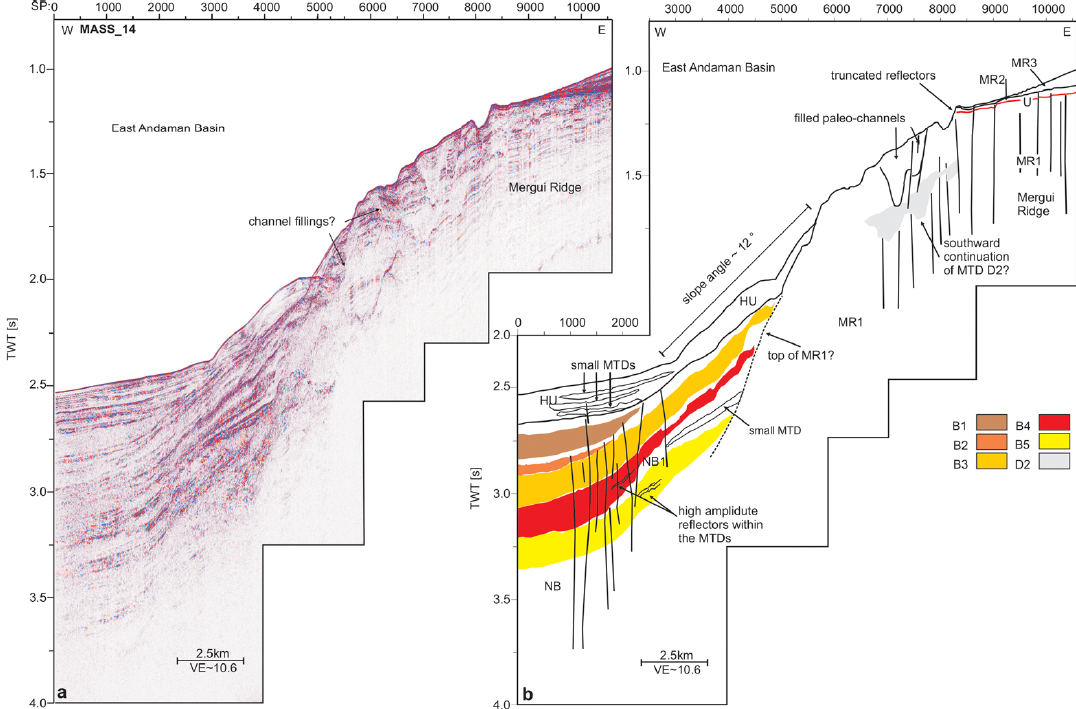
Fig. 6. (a) Seismic profile MASS 14, running across the basin-ridge transition in the northern working area, with channel-fillings indicated at the edge of Mergui Ridge. (b) Interpreted profile showing Mergui Ridge units MR1–MR3 in the east and basin sediments NB and HU in the west. The black lines mark boundaries between the seismic units. The red line denotes the position of unconformity U . The black stippled line marks the possible upper boundary of MR1. Channel fillings are present in the upper part of MR1. The reflectors of the upper Mergui Ridge units (MR2 and MR3) are truncated at the edge of the ridge. At the edge of the ridge a U-shaped structure is present, indicating an approximate slope parallel paleo-channel. The coloured areas mark the position of the stacked MTDs B1–B5 and a possible southward continuation of MTD D2. See text for further explanations and Figs. 2 and 3 for location of the